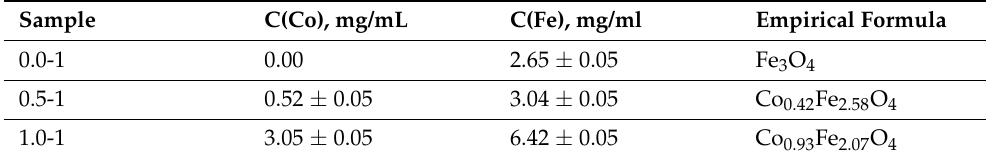
Table 3. MS AES data for the x = 0.0-1, x = 0.5-1 and x = 1.0-1